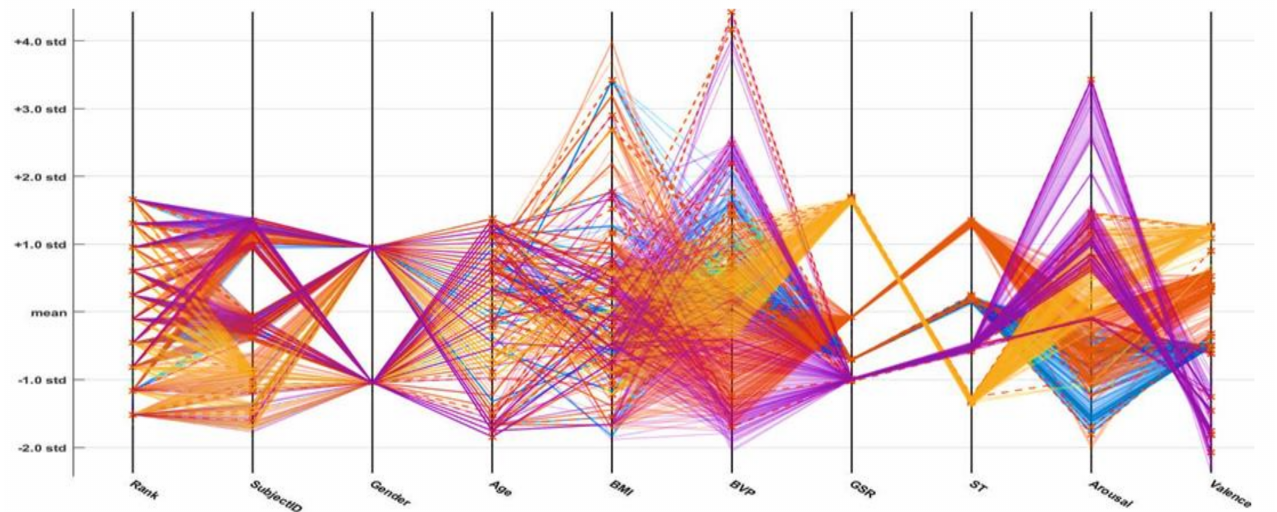
Figure 17. Parallel coordinate plot for the support vector